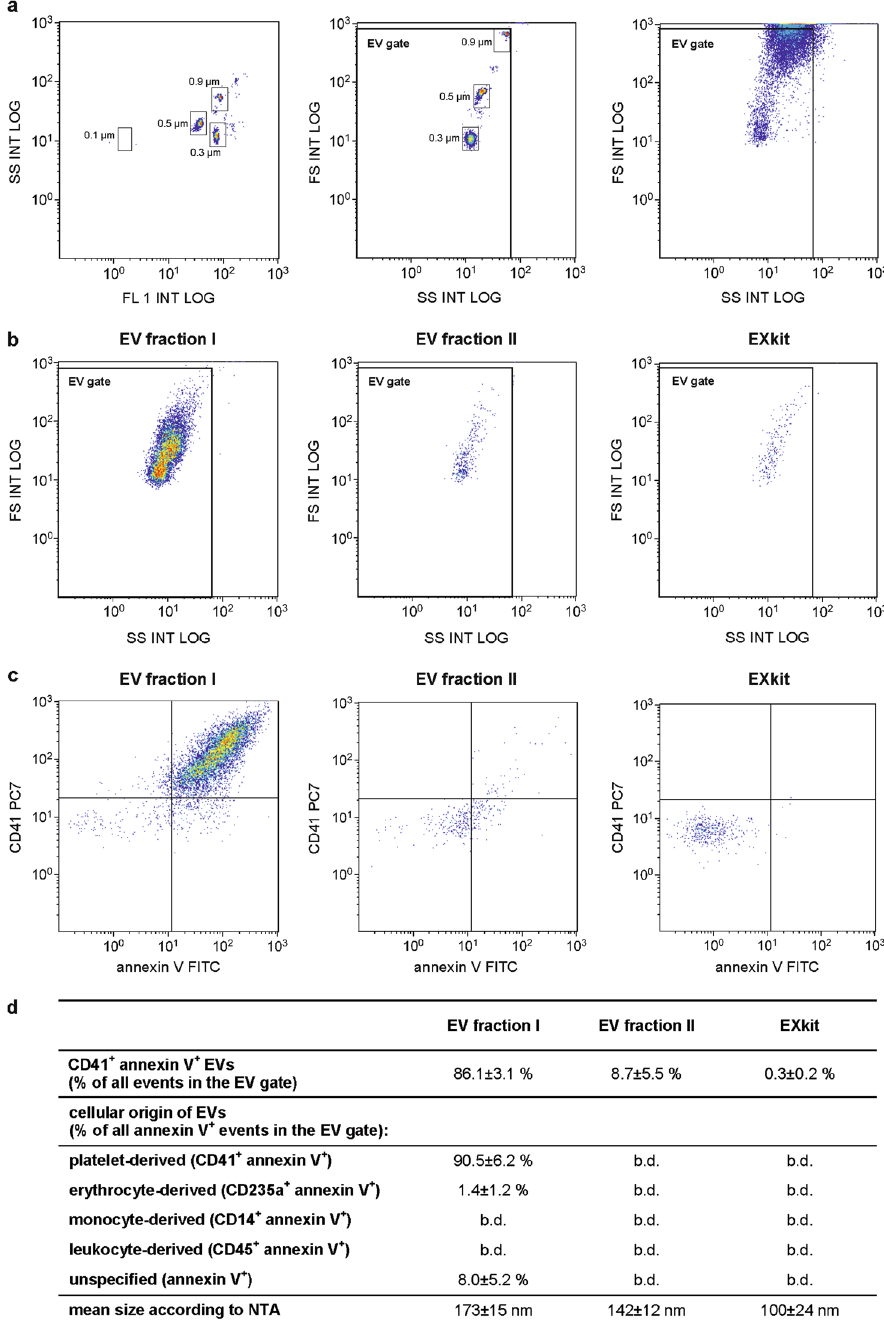
Figure 2. Flow cytometric characterization of isolated EV fractions. EVs were isolated from platelet concentrates as shown in Fig. 1. ( a ) Flow cytometric characterization was performed after calibration with fluorescent beads (0.1, 0.3, 0.5, and 0.9 µ m; left panel), and the EV gate was set above the 0.9 µ m bead cloud as described in the Methods section (middle panel). A forward scatter vs . side scatter (FS vs . SS) dot plot for platelet concentrate is shown as example (right panel). ( b ) EV fractions obtained by differential centrifugation of the platelet supernatant at 20,000 g and 100,000 g (EV fraction I and II) or by polymer precipitation (EXkit) are shown in FS vs . SS dot plots. ( c ) Characterization of EVs using CD41 as platelet marker and annexin V as marker for phosphatidylserine exposing EVs. Forward scatter vs . side scatter plots as well as CD41 vs . annexin V scatter plots are shown for all EV fractions. ( d ) Characterization of the EV fractions, specification of the cellular origin of EVs in fraction I, and average vesicle size in EV fractions according to nanoparticle tracking analysis (NTA). The following markers were used to specify the cellular origin of EVs: CD41 (platelet), CD235a (erythrocyte), CD14 (monocyte), and CD45 (leukocyte). The flow cytometric detection limit of 250 nm prohibited a reliable differentiation of EVs in fraction II and in the EXkit fraction with respect to their cellular origin. Data represent the mean of 6 independent isolation experiments ± standard deviation. b.d., below the detection